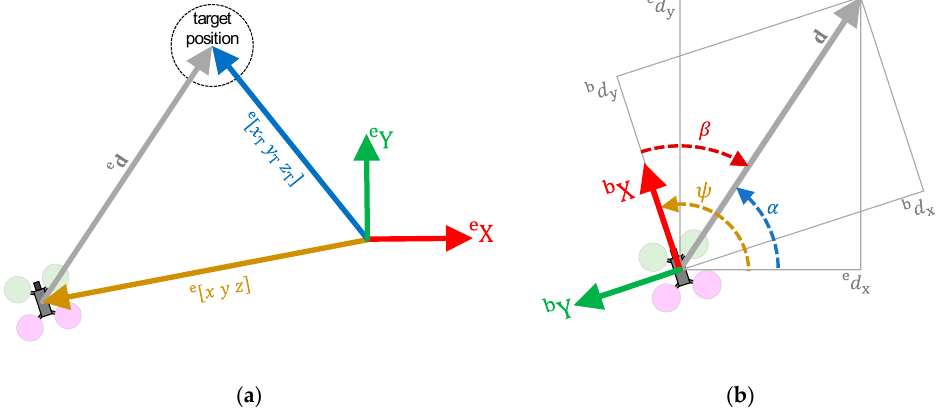
Figure 11. Transformation of ( a ) position and ( b ) bearing from the global (earth) reference system to the local (body) reference system.